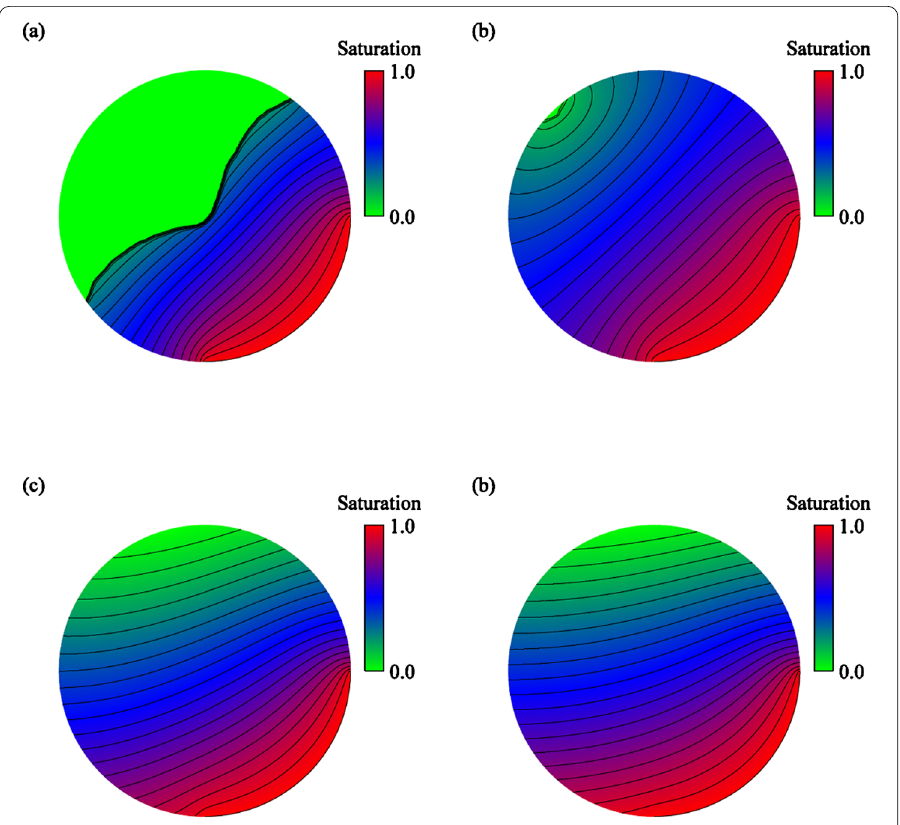
Figure 11 Computed saturation at each time for the vertical displacement. Computed saturation at the times (a) 0.6 × 10 3 (s), (b) 1.2 × 10 3 (s), (c) 4.8 × 10 3 (s), and (d) 4.8 × 10 4 (s) (almost steady state), respectively. The contour lines for u = 0.05 n where n represent non-negative integers are